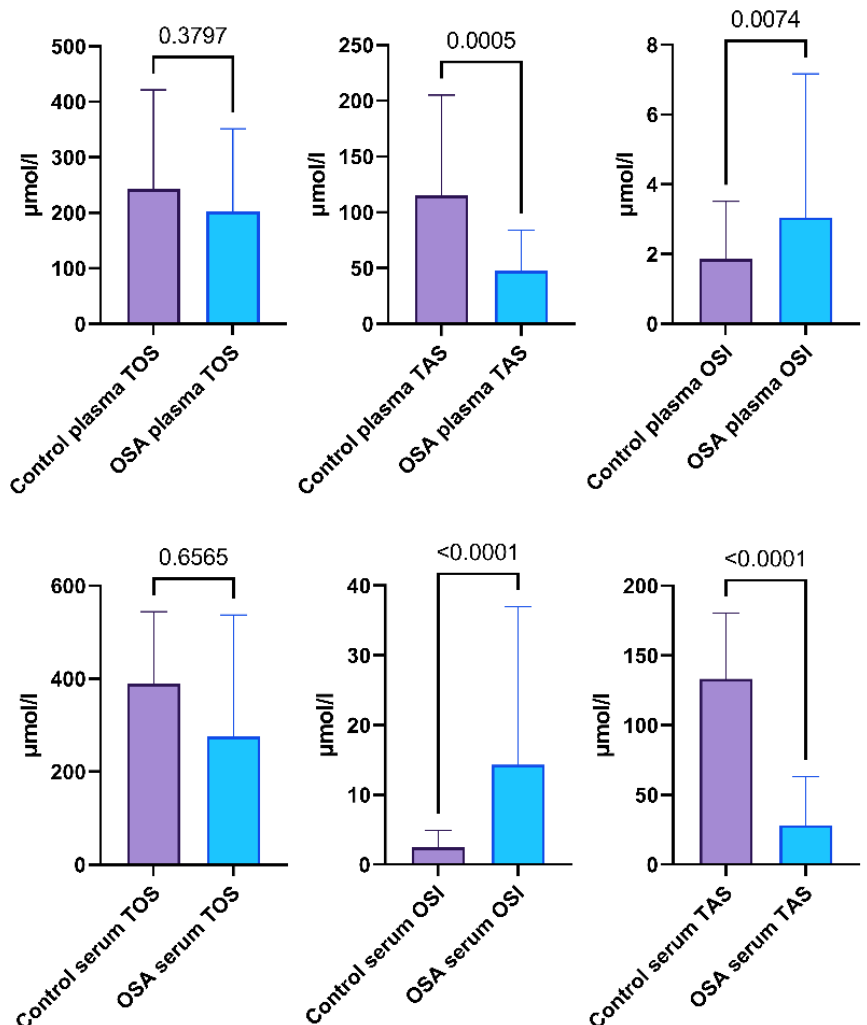
Figure 4. Total oxidative status (TOS), total antioxidative status (TAS), and oxidative stress index (OSI) of the serum and plasma of the participants from the OSA group and control group. Data represent the median and interquartile range and p -value of the OSA group vs. the control group. Table 5. Mutual dependences between the investigated parameters.